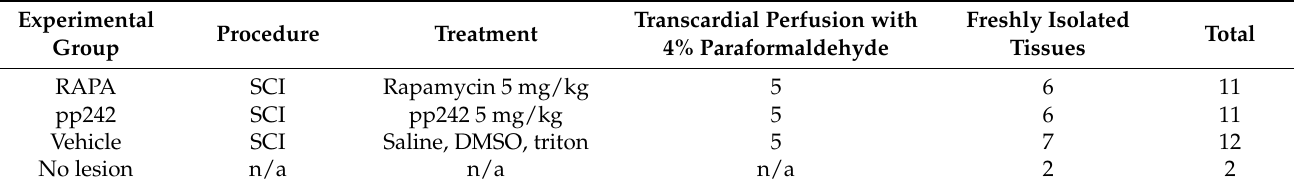
Table 1. Experimental groups of rats used in the